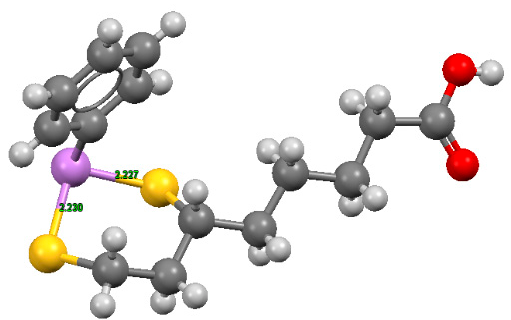
Figure 4. Structures of phenylarsenic with DHLA, where hydrogen is shown in light grey, carbon in grey, sulfur in yellow, oxygen in red, and As (III) in violet. The coordinates were obtained from the Cambridge Structural Database (NIDKAM), and the image was created using Mercury3.5.